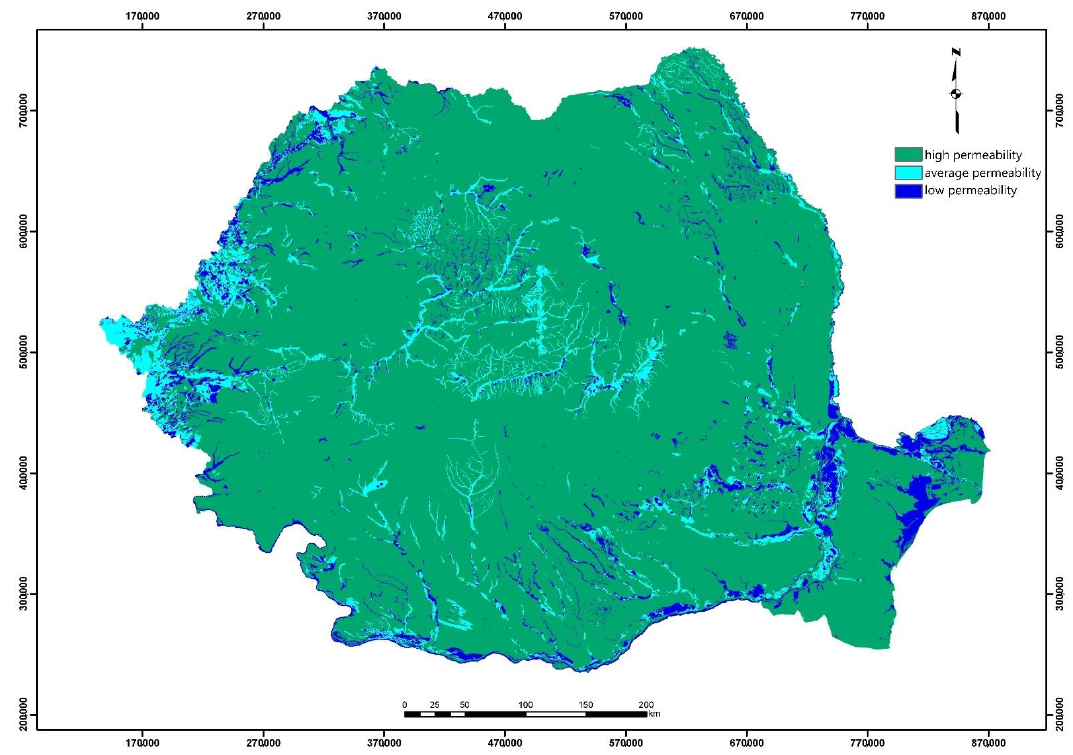
Figure 7. Initial processing of input data: soil permeability map. Table 7. Results of the evaluation for WRASTIC index: Industrial activities (I); Recreational activities (R); Wastewater (W); Size of watershed (S); Ways of transport (T); Cover (vegetation) (C); Irrigation (a); Agricultural activities (A).